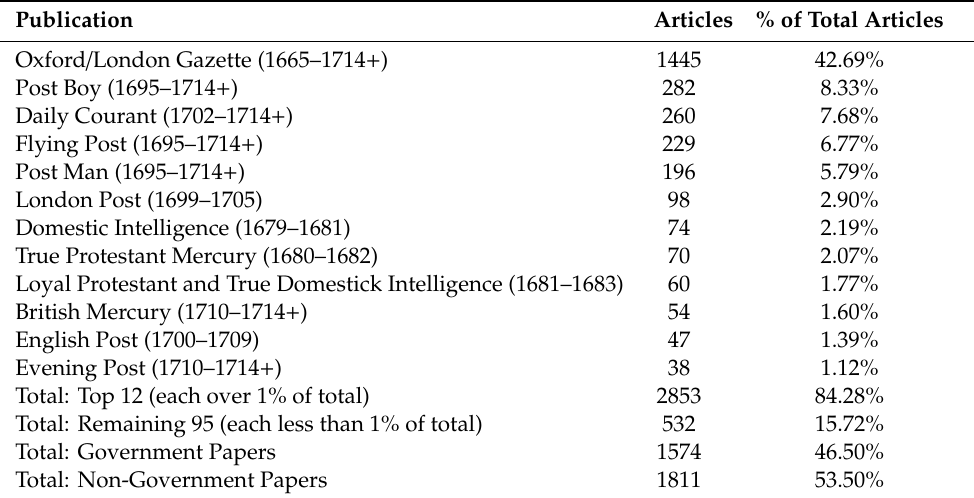
Table 7. Articles relating to the Maghreb by